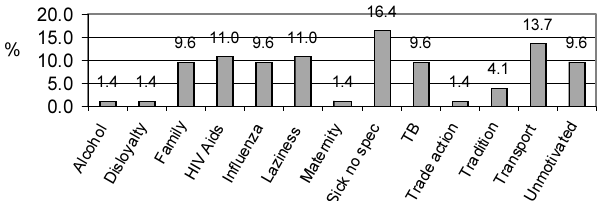
Figure 4: Absent from work